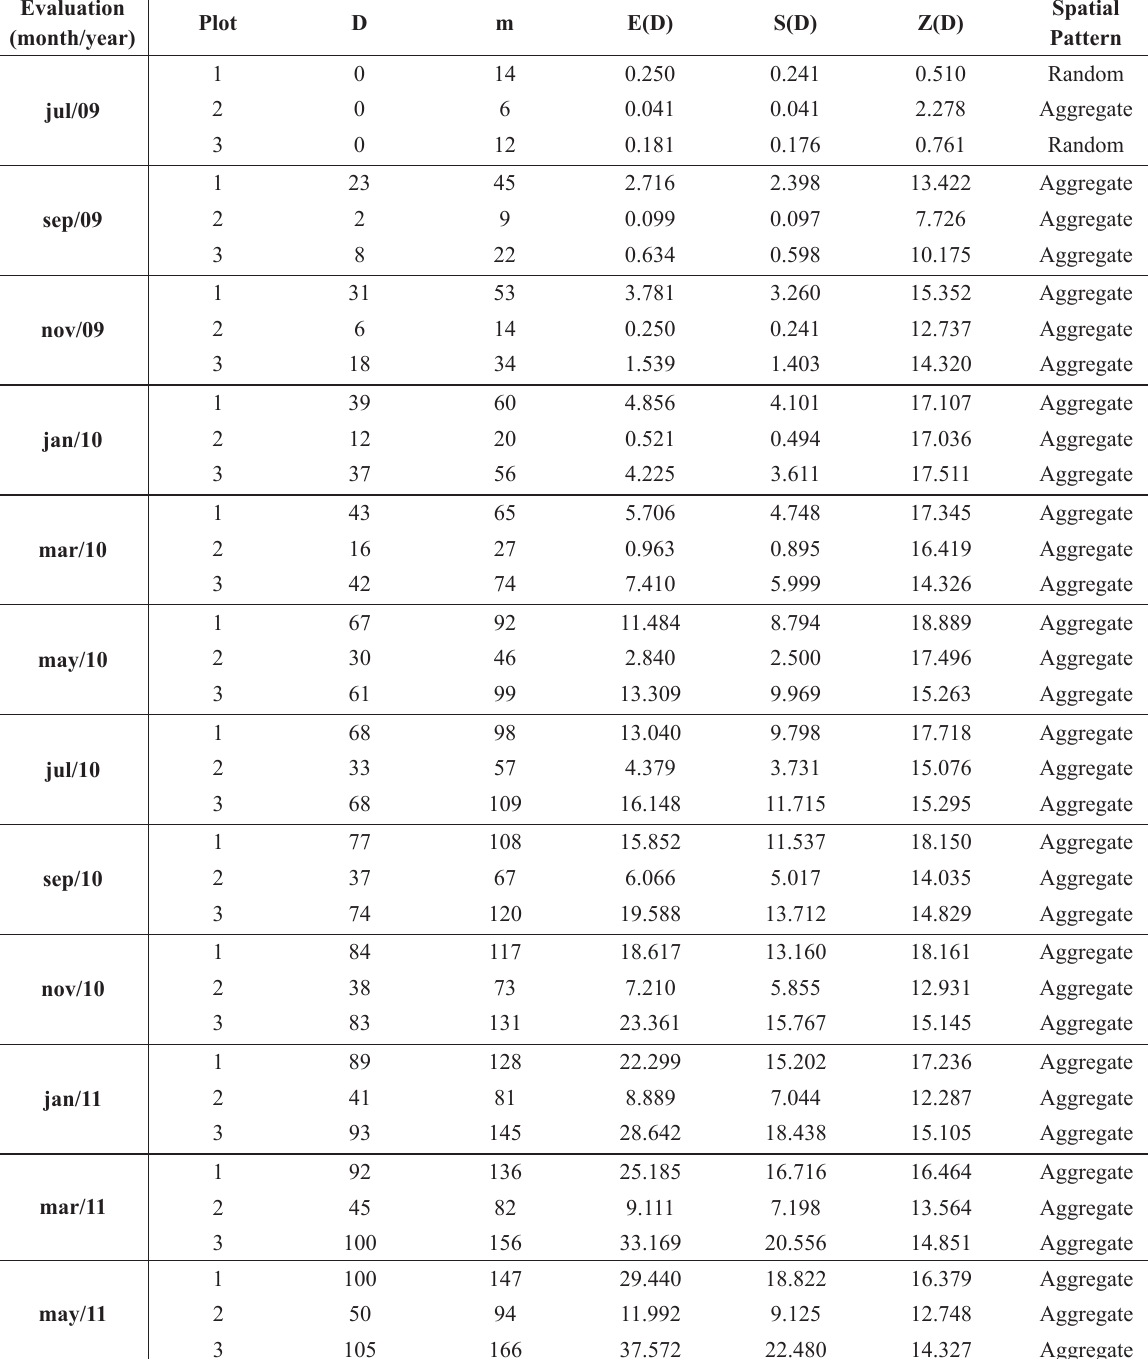
Spatial arrangement of coconut stem bleeding analyzed by doublet